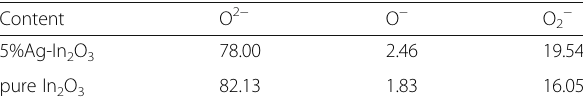
Table 1 The ratio of chemical component of 5%Ag-In 2 O 3 and pure In 2 O 3